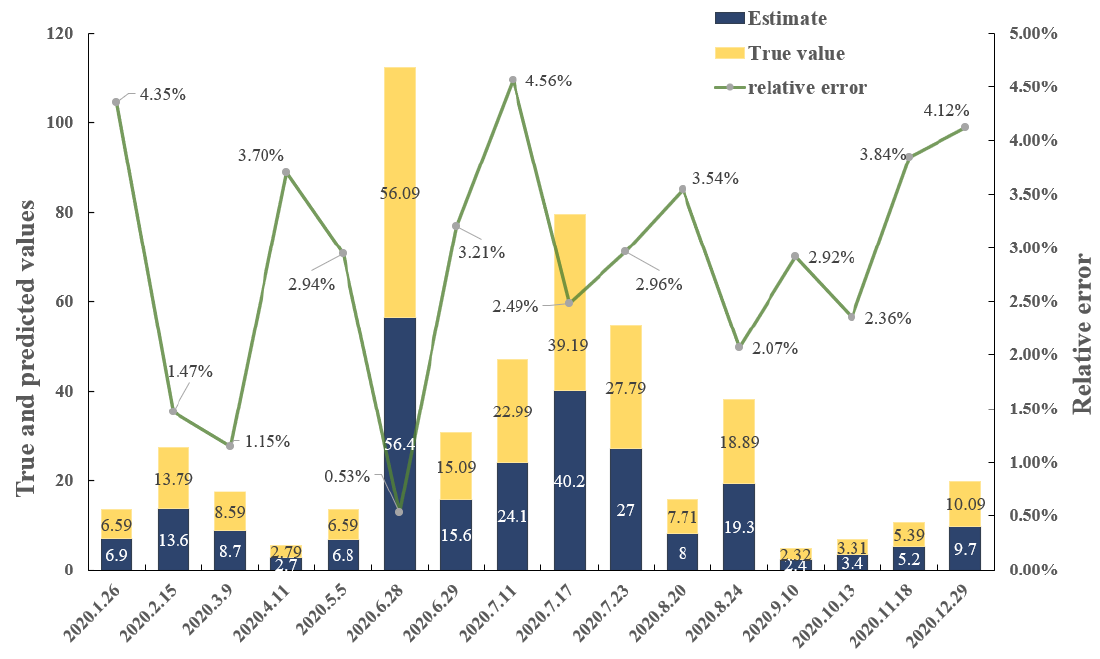
Figure 14. Comparison of rainfall forecast results.